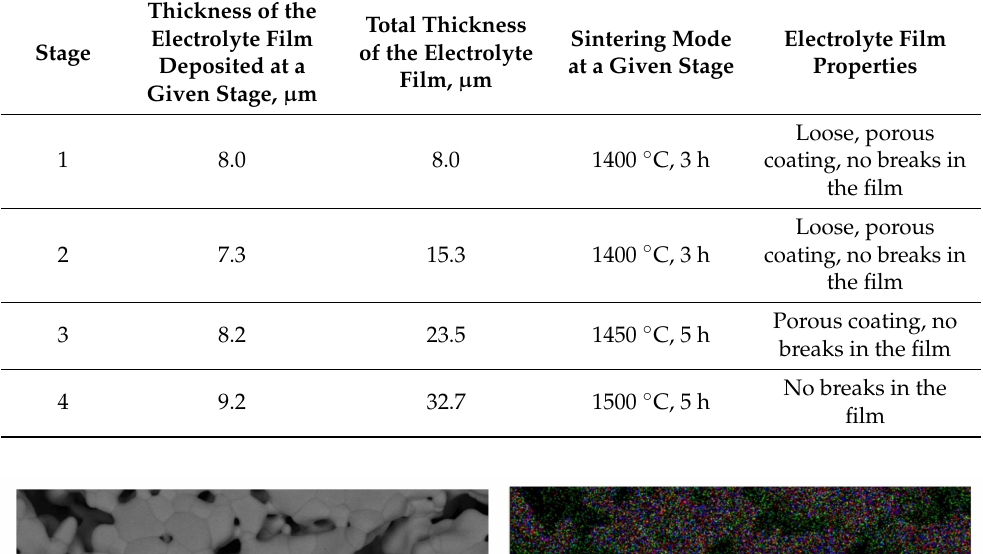
Table 2. Cycles of deposition-sintering of the SDC electrolyte layer on the NiO-SDC anode substrate with a platinum sublayer: thickness, sintering modes and the electrolyte film properties.